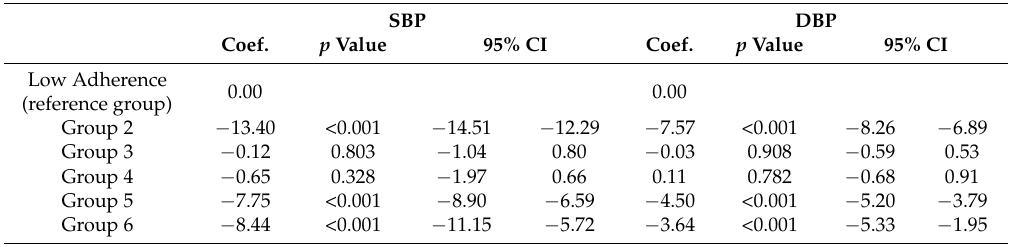
Table 2. SBP and DBP values according to 6 trajectories of MDA.